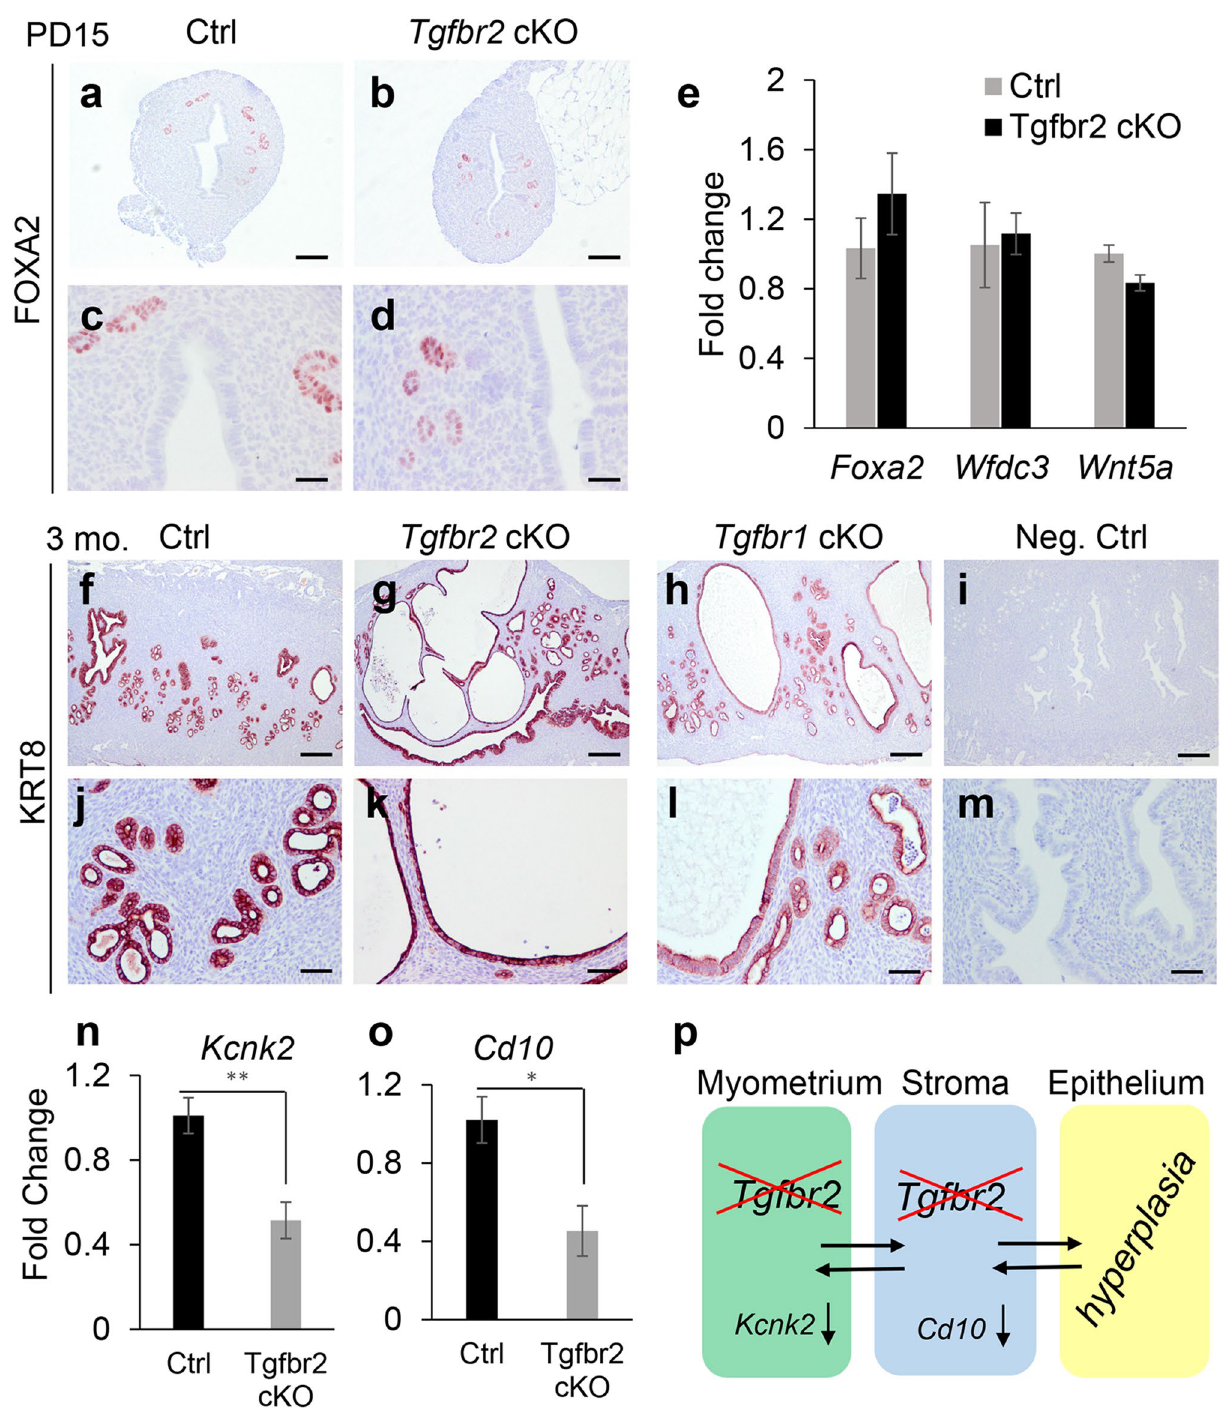
Figure 4. Development of endometrial pathology in adult Tgfbr2 cKO. ( a–d ) Immunostaining of FOXA2 in the uteri of controls and Tgfbr2 cKO at PD15. ( e ) Transcript levels of gland-associated genes in the uteri of controls and Tgfbr2 cKO at PD15. n = 3. ( f–m ) Immunolocalization of KRT8 in the uteri of controls, Tgfbr2 cKO, and Tgfbr1 cKO. Negative controls using isotype-matched IgG are representatively shown in ( i , m ). ( c , d , j – m ) Represent higher magnification images for ( a , b , f – i ). Three independent mice were examined for each genotype. Scale bar equals 25 µm ( c , d ), 50 µm ( j – m ), 100 µm ( a , b ) and 250 µm ( f – i ). ( n , o ) Transcript levels of Kcnk2 and Cd10 in the uteri of controls and Tgfbr2 cKO at PD10. n = 4. * P < 0.05, ** P < 0.01. ( p ) Potential interactions among uterine smooth muscle cells, stromal cells, and epithelial